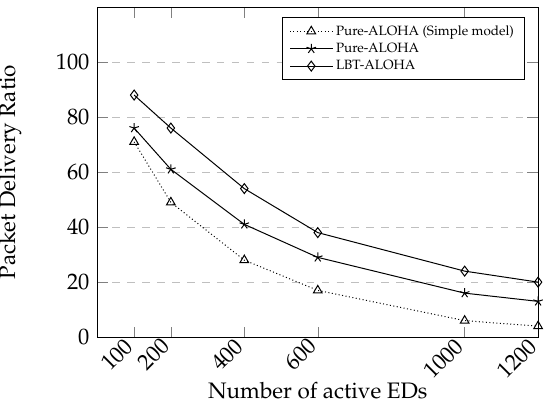
Figure 7. Packet delivery ratio (PDR) comparison between Pure-ALOHA without capture effect and Pure-ALOHA and LBT-ALOHA with capture effect. The capture effect and LBT approach contribute to in improving LoRa